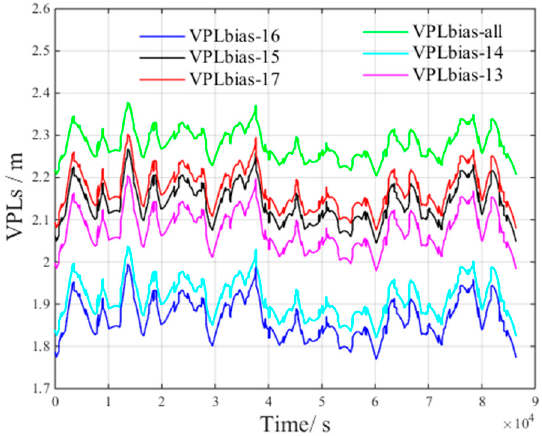
VPL Figure 13. VPL bias of different satellite subsets under non-nominal Figure 13. of different satellite subsets under non-nominal troposphere. Figure 13. of different satellite subsets under non-nominal troposphere. bias